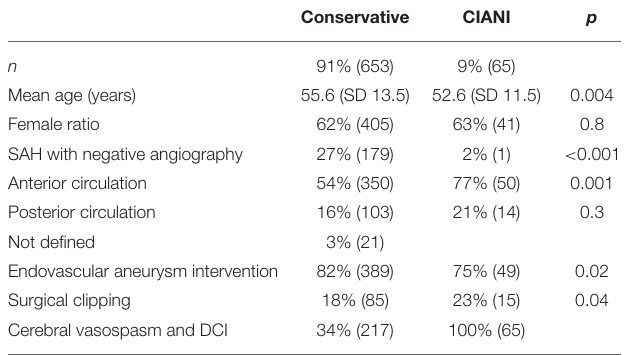
TABLE 1 | Patients’ clinical characteristics. TABLE 2 | Initial grading scores of patients with subarachnoid